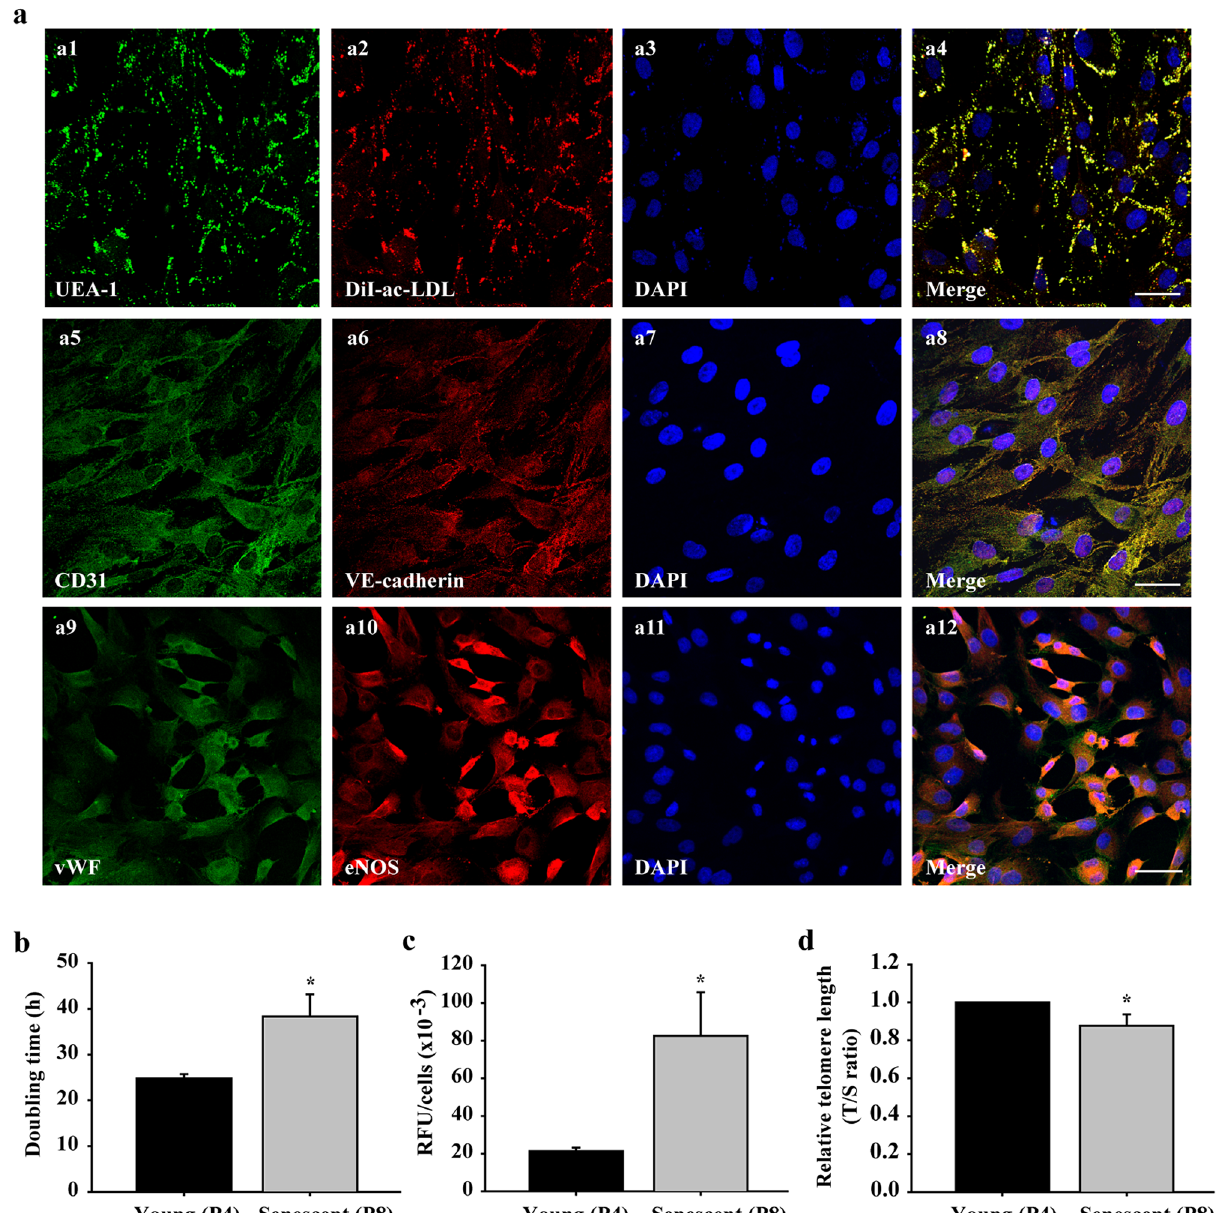
Figure 1. Characterization of EPCs and comparison of young (passage 4, P4)/senescent (passage 8, P8) porcine EPCs. Subconfluent EPCs were fixed with 4% paraformaldehyde (PFA) and stained with the indicated antibodies against UEA-1 (green a1). EPCs were incubated with DiI-labelled ac-LDL (red) for 4 h before PFA fixation (a2). Cell nuclei were visualized by DAPI staining (blue, a3, a7 and a11). Images were then merged (a4, a8 and a12). Cells were stained with anti-CD31 and anti-VE-cadherin (a5 and a6) antibodies. Panels a9 and a10 show cells stained with anti-vWF and anti-eNOS antibodies. Images were acquired by confocal microscopy with a 40 × (oil, na 1.30) magnification objective (SP8, Leica, Germany). Scale bar: 50 μm. P4 (young group) and P8 (senescent group) cells were evaluated for doubling time using a cell counting kit-8 (CCK-8; b ), for acidic β -galactosidase activity using acidic β -galactosidase staining ( c ), and for telomere length using real-time PCR ( d ). The telomere (T) repeat copy number was normalized to the single-copy (S) gene 36B4 copy number. The T/S ratio of the control group was set as 1. n = 6 for each bar. * P < 0.05 vs. the young (P4) group. h = hours. RFU = relative fluorescence